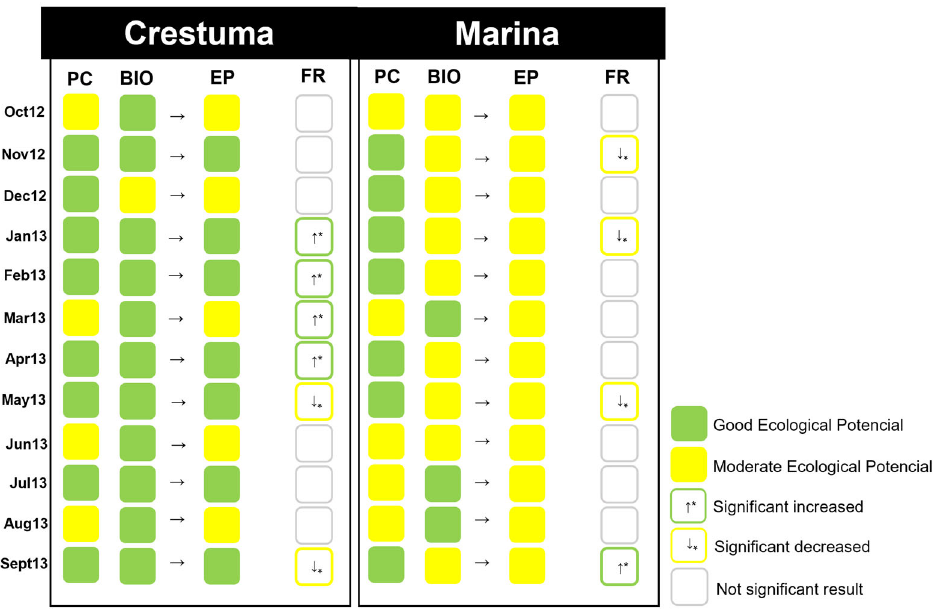
Figure 3. Physical and chemical (PC), biological (BIO) elements, and final ecological potential (FP from Tables 1 and 2) classification for Crestuma and Marina water samples, from each sampling period. Daphnia magna feeding rate (FR from Figure 2) results were also presented as additional water evaluation data. Green—Good Ecological Potential (GEP); Yellow—Moderate Ecological Potential (MEP). FR color evaluations were performed according to the classes of disturbances described in Rodrigues et al., [34].